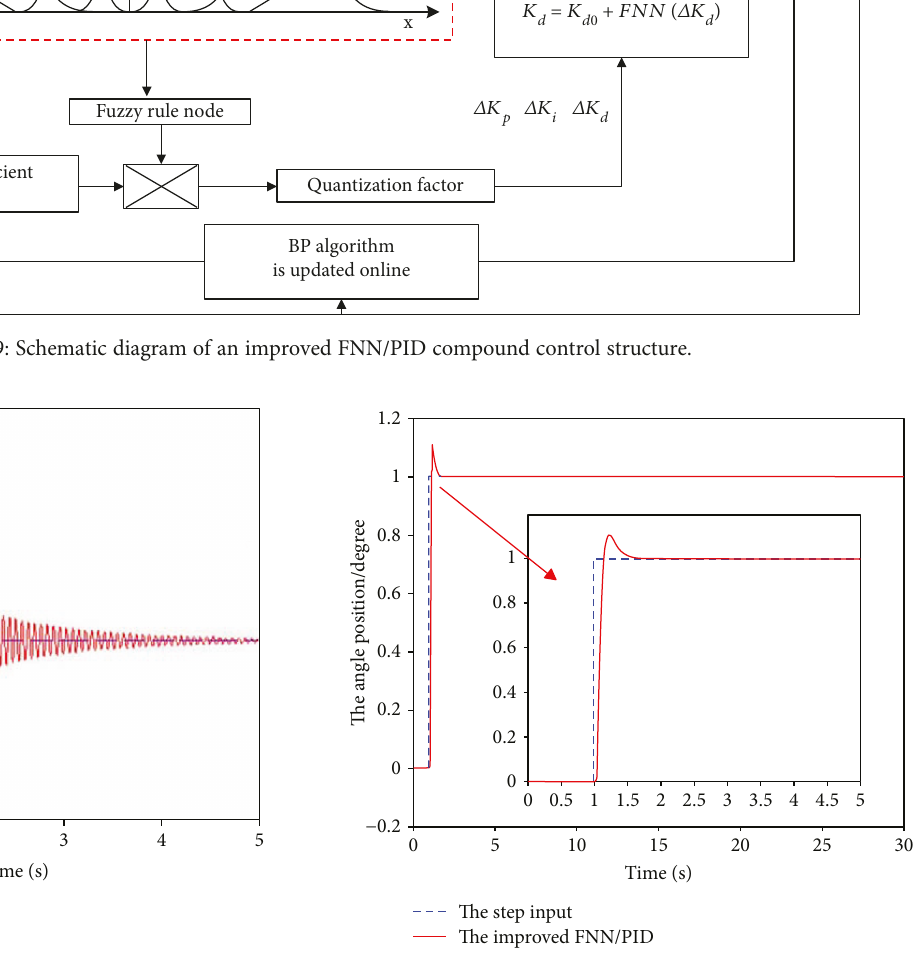
Figure 11: System response curve between the improved FNN/PID compound control scheme and step input. Table 2: Comparison of the accuracy of each method step response in di ff erent time